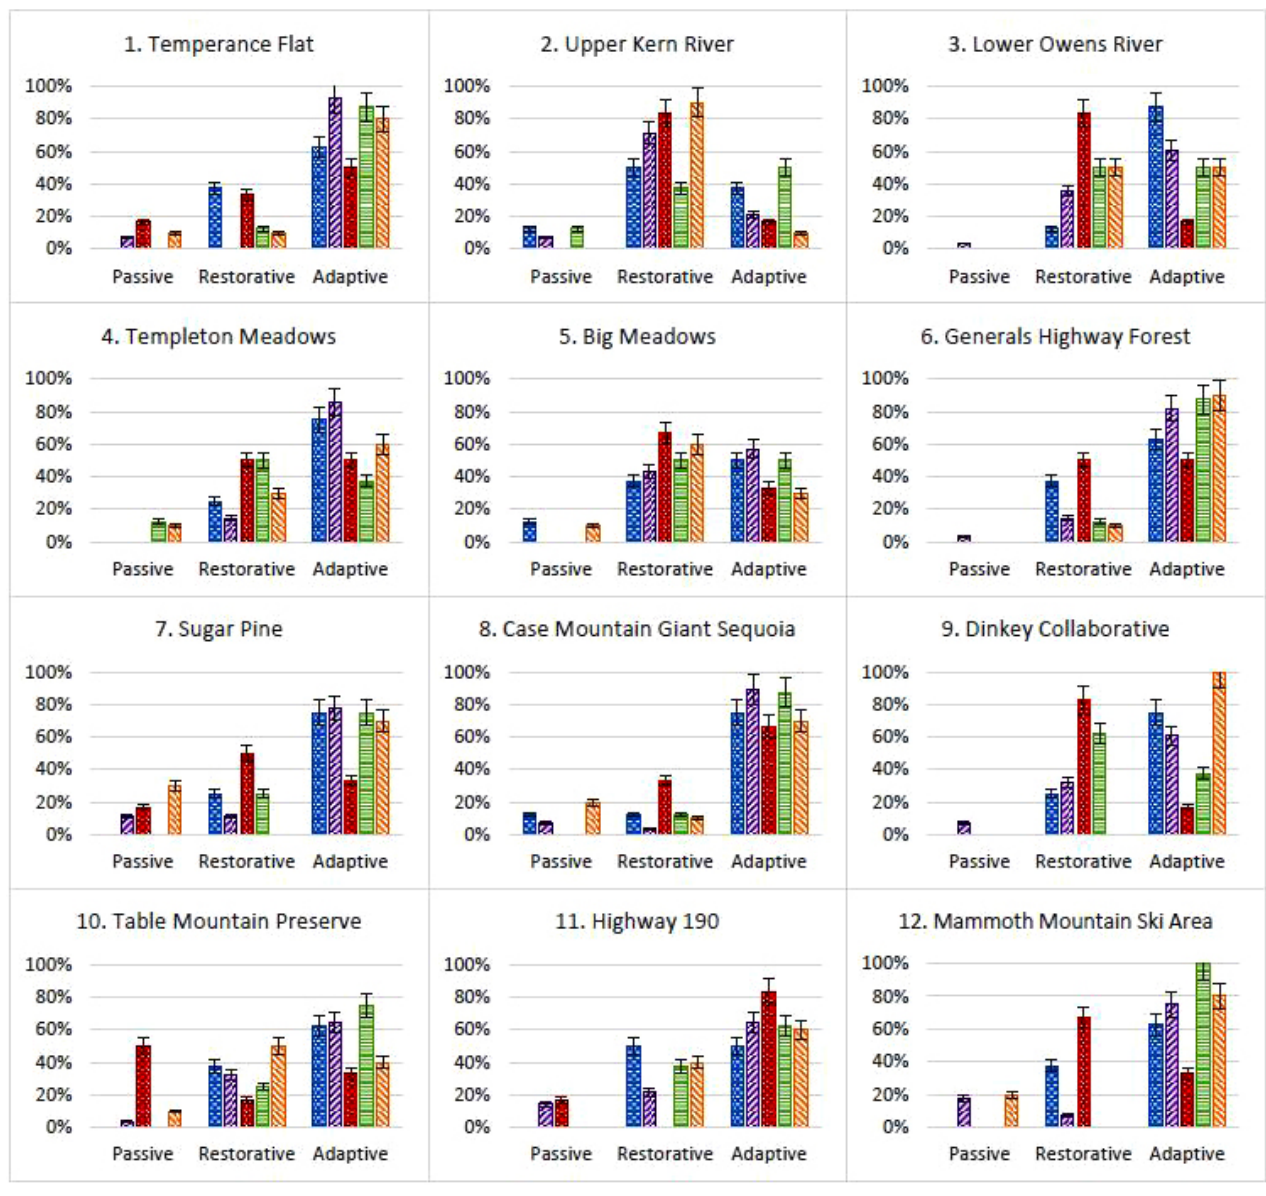
Fig. 6 . Strategy responses by professional category for each site (with standard 10% error